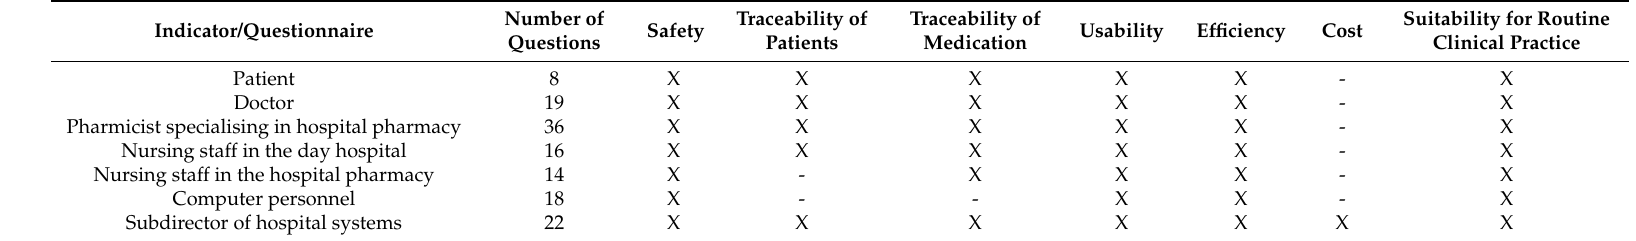
Table 5. Thematic content of the questionnaires developed for each professional